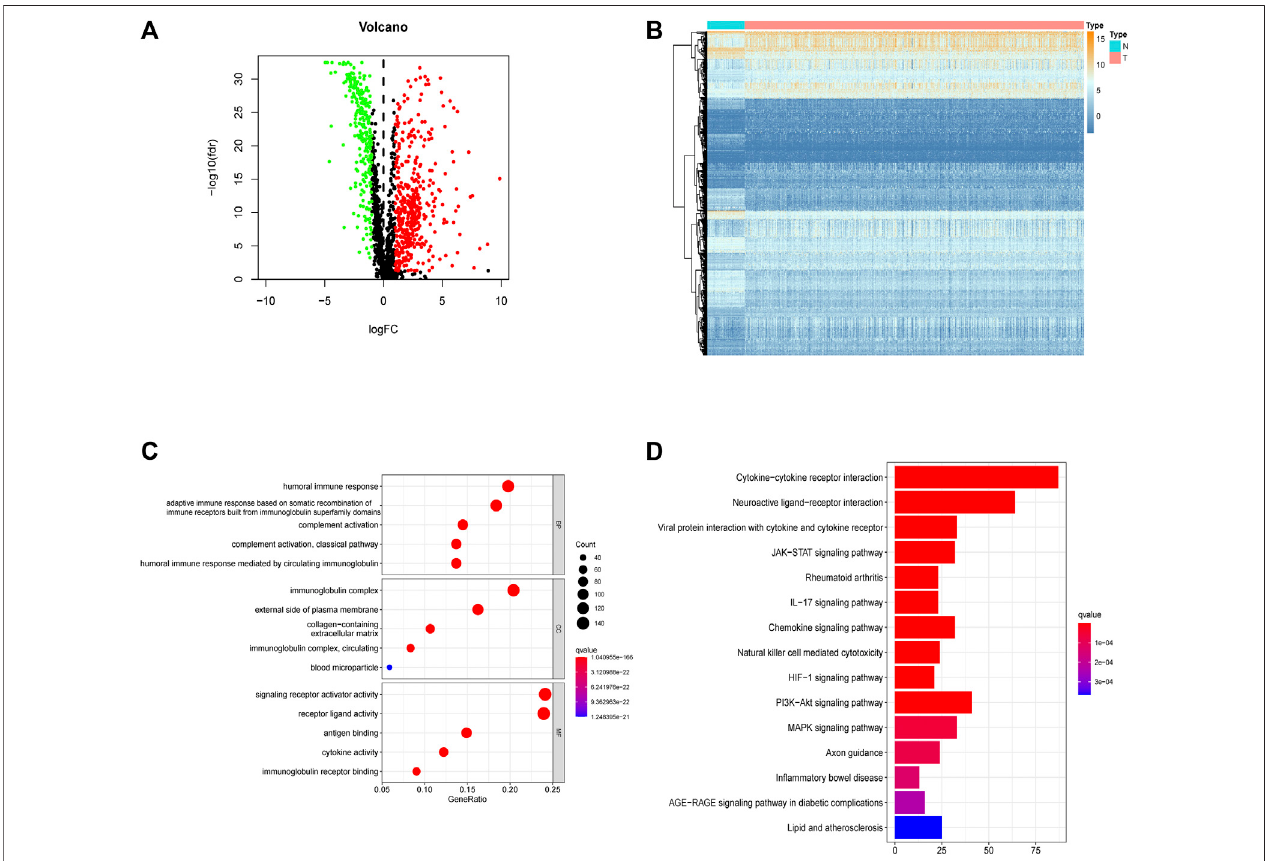
FIGURE3| Integrallyscreeningofdifferentiallyexpressedhypoxia,immunityandEMTrelatedgenes. (A) VolcanoplotsoftheintegratedDEGs. (B) Heatmapsofthe integrated mRNAs. (C) GO enrichment based of integrated DEGs. (D) KEGG pathways of integrated DEGs.